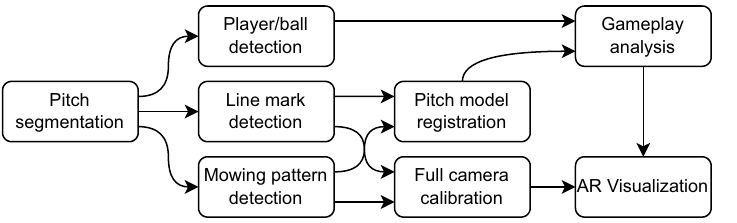
Figure 1. Possible system pipeline including the proposed method as a first